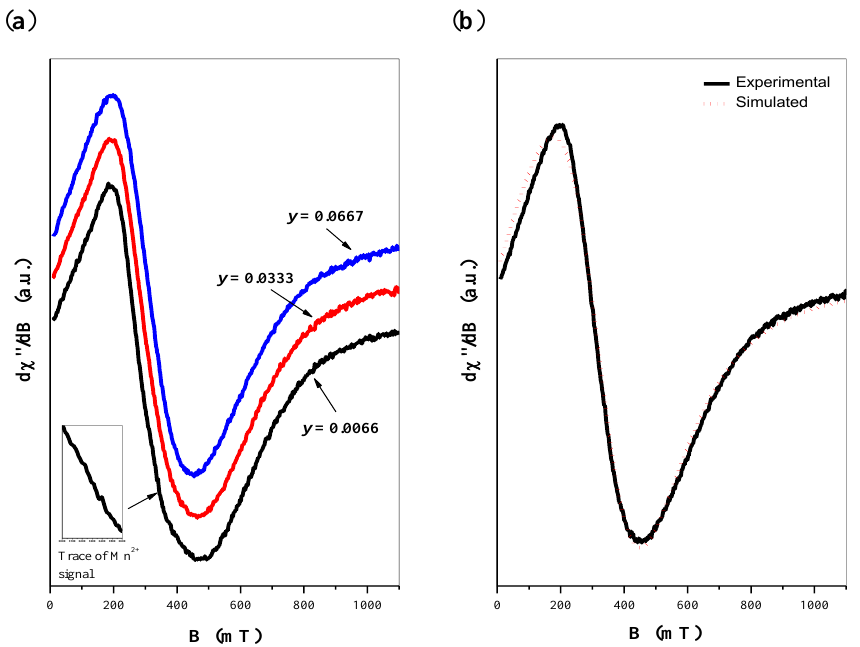
Figure 11. EPR spectra of CaMnGdMoWO samples with fixed Gd 3+ content x = 0.1667 obtained by solid state reaction method ( a ); EPR spectrum of CaMnGdMoWO sample with y = 0.0667 and its simulation by Dysonian function ( b ).